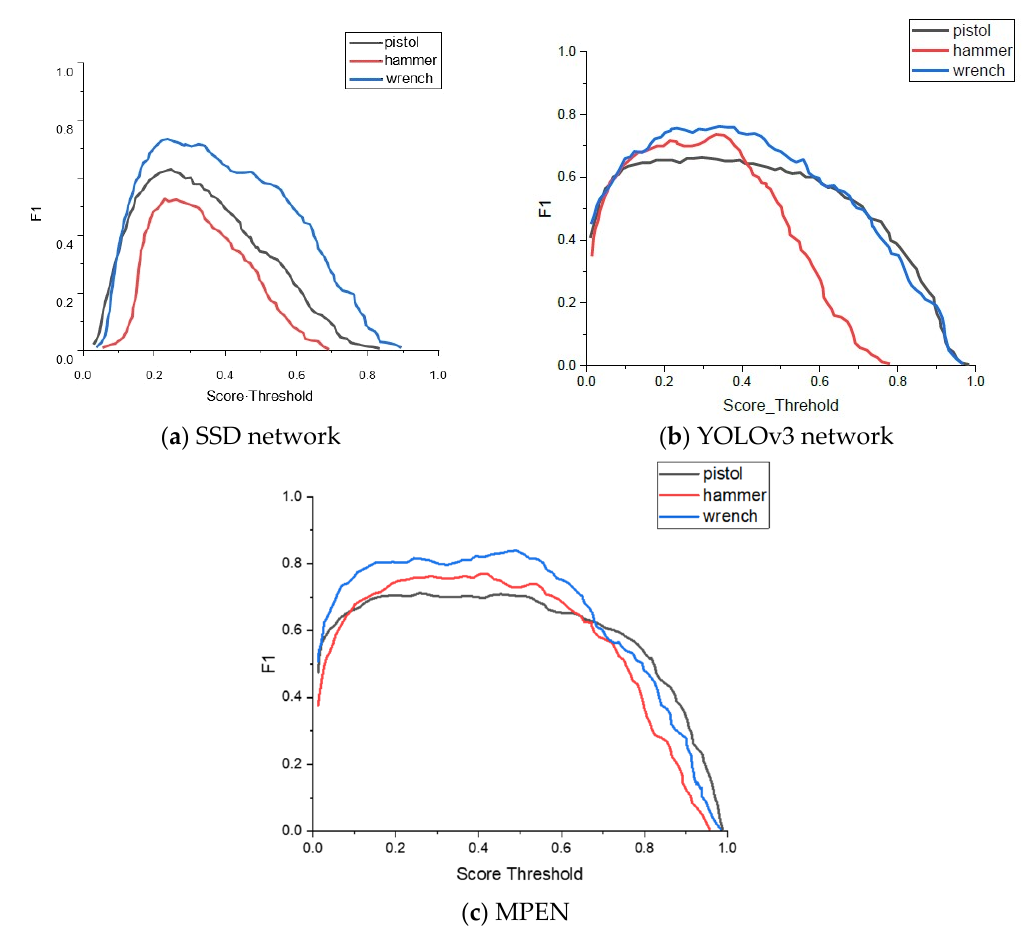
Figure 10. Schematic diagram of each network F